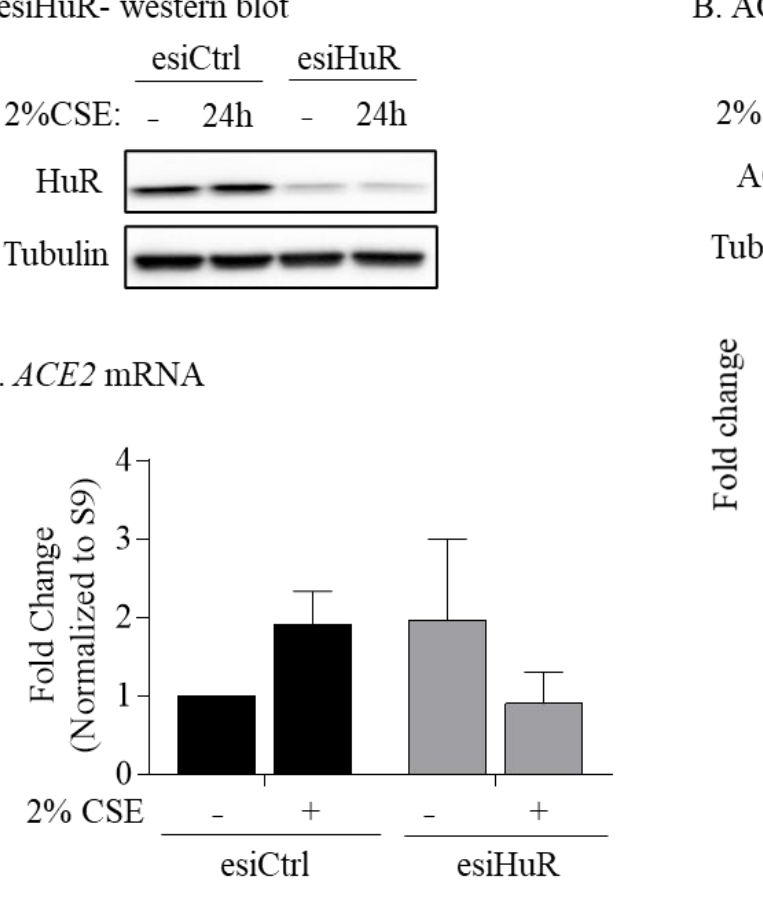
Figure 9. HuR silencing does not affect protein and mRNA expression of ACE2. ( A ) HuR protein— Western blot: transfection of non-smoker HLFs with esiHuR reduced the level of HuR protein by ~80%. ( B ) ACE2 protein: there was no significant difference in ACE2 protein levels in esiHuR-transfected HLFs exposed to 2% CSE for 24 h compared to untreated esiHuR-transfected cells and to esiCtrl-transfected cells. Results are expressed as the mean ± SEM of 3 independent experiments (HLFs used from one non-smoker subject). ( C ) ACE2 mRNA: there was no significant difference in ACE2 mRNA in esiHuR-transfected HLFs exposed to 2% CSE for 24 h compared to untreated esiHuR-transfected cells and to esiCtrl-transfected cells. Results are expressed as the mean ± SEM of 3